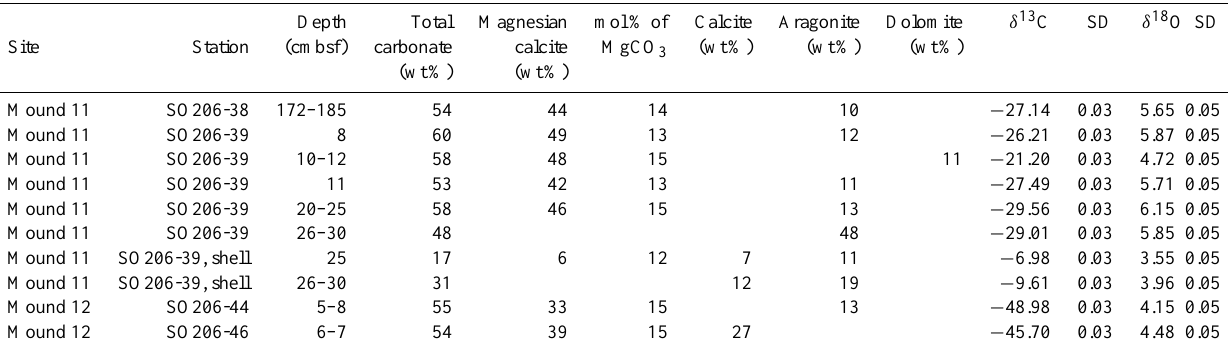
Table 5. Mineralogy and stable isotope composition of carbonate samples from Mound 11 and 12 (cruise SO206). The standard deviation (SD) of lab standard is given.